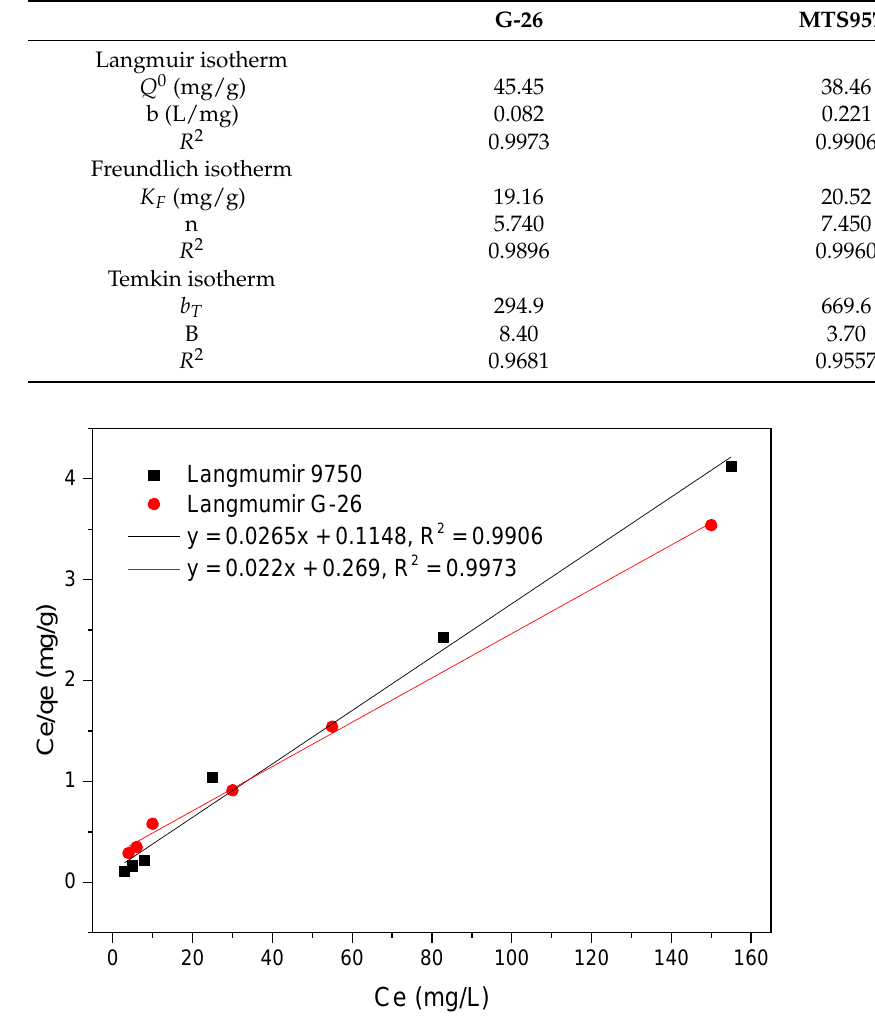
Figure 8. Langmuir isotherm of Pb(II) adsorption on G-26 and MTS9570.